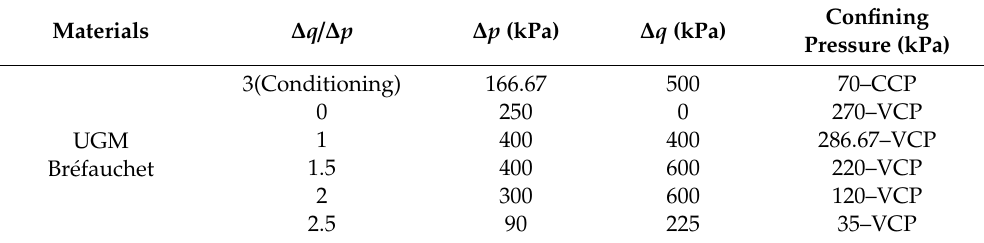
Table 2. Stress paths used in conditioning phase and resilient test